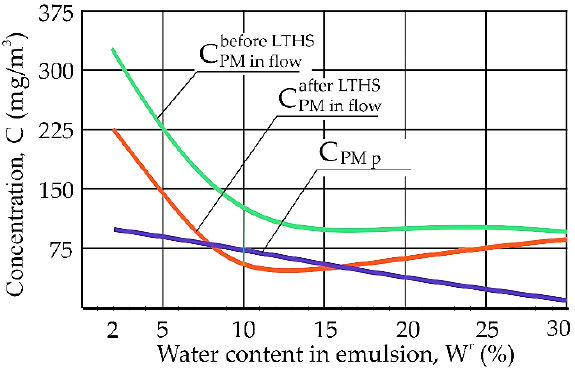
Figure 12. Dependences of the PM concentration in the exhaust gases before and after LTHS.